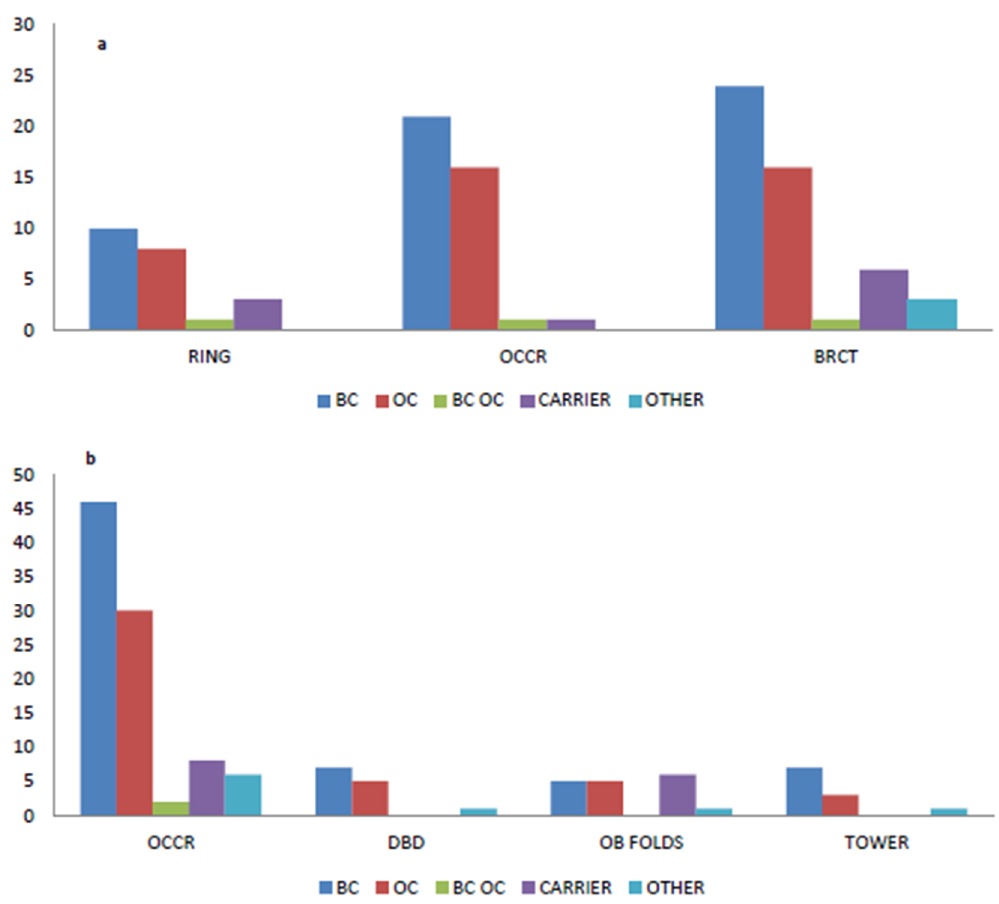
Figure 3. The histograms represent the absolute number of patients divided by BC, OC, BC / OC, carrier or other that show a variant located within one of the classic domains of the BRCA1 ( a ) or BRCA2 ( b ) genes.